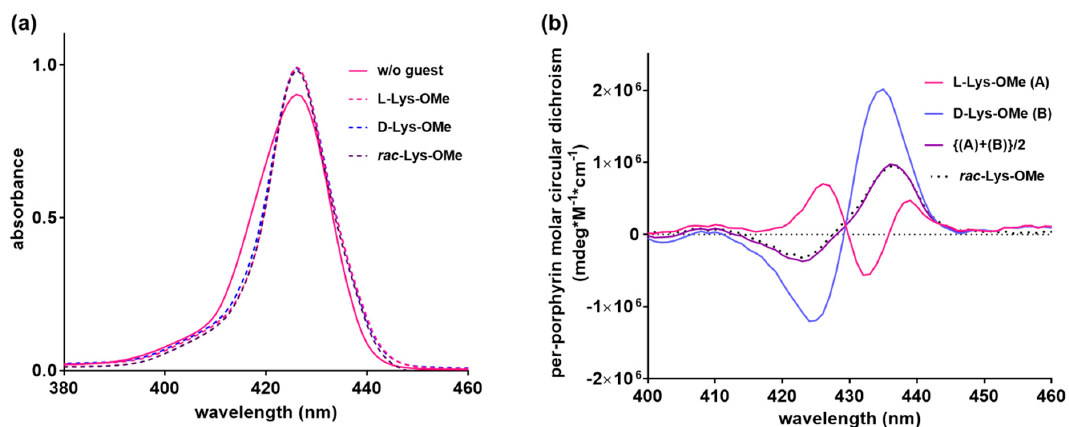
Figure 7. ( a ) UV-vis and ( b ) CD spectra of 2 (1 µ M in CH 2 Cl 2 ) with 17 equivalences of L -Lys-OMe, D -Lys-OMe or racemic Lys-OMe.